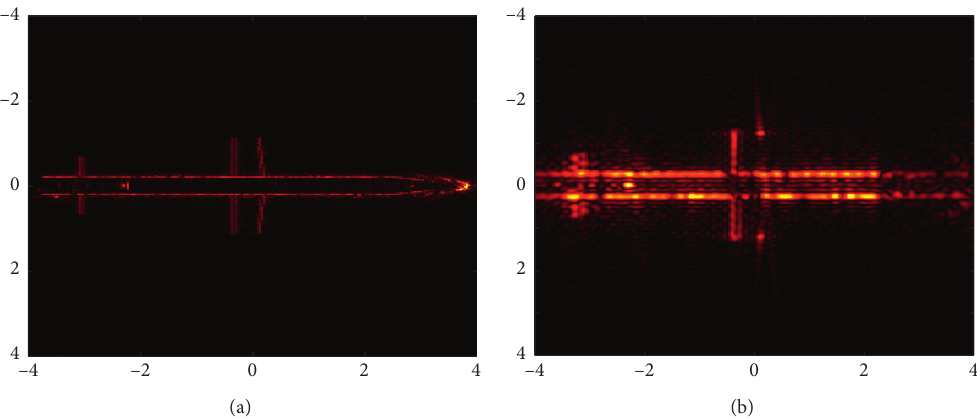
Figure 14: Final multiview ISAR image of the missile model. (a) Simulated by large-angle and wide-bandwidth data. (b) Simulated by small- angle and narrow-bandwidth data.